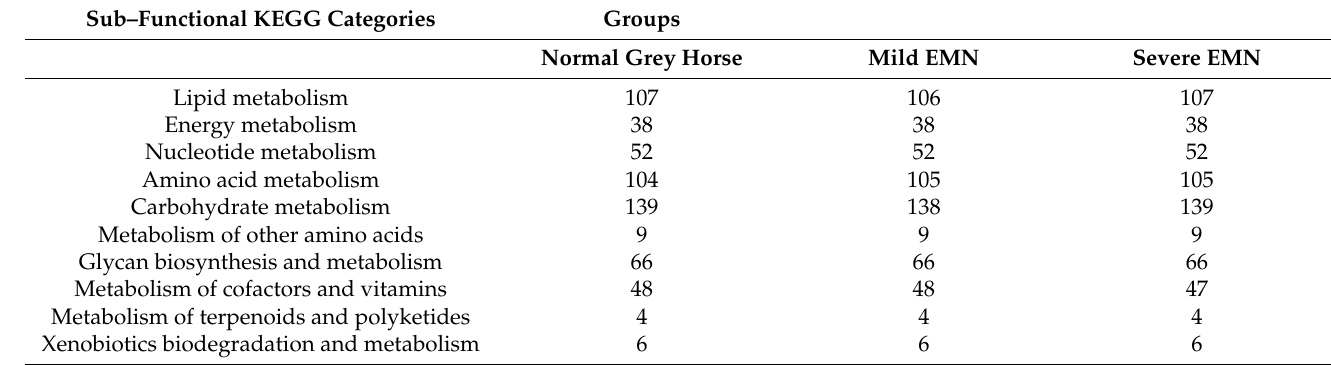
Table 4. Sub–functional KEGG categories 3 groups of the experimental grey horses EMN of the faeces